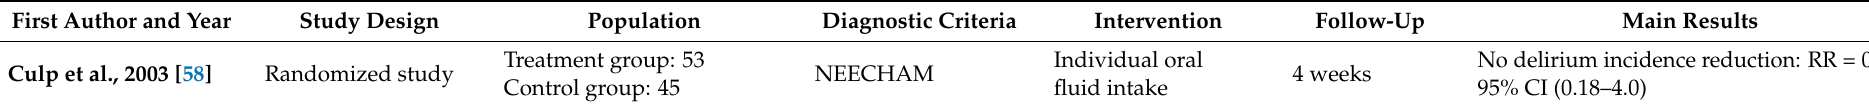
Table 2. Main Characteristics of studies investigating prevention strategies and interventions to reduce delirium occurrence in nursing